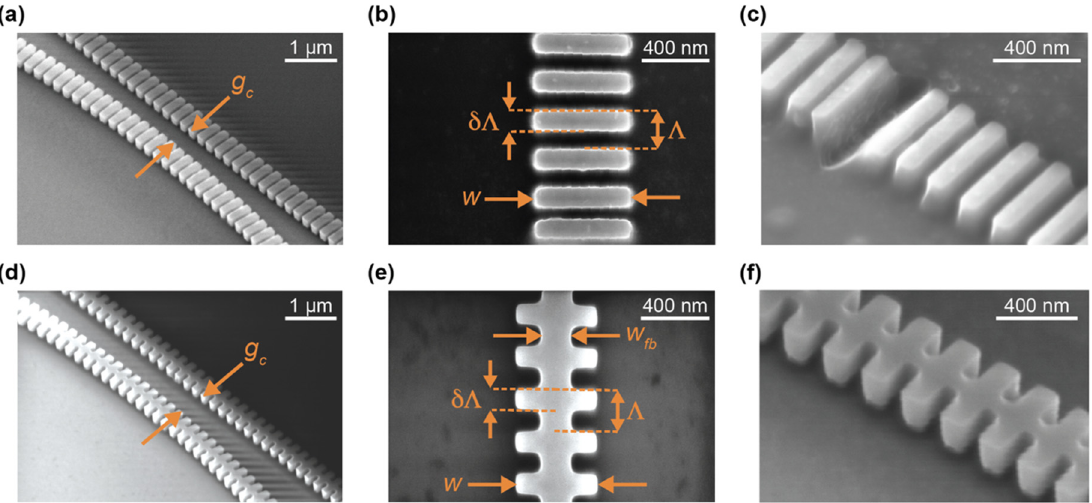
Figure 7. Scanning electron microscope images of fabricated SWG MRRs. ( a ) 45° angled view of coupling region for a boneless SWG MRR, ( b ) top-view of boneless SWG waveguide O4, ( c ) 45° angled view of boneless SWG waveguide O4, showing collapsed silicon pillars after testing, highlighting robustness issues with this boneless design (we did not observe any collapsed pillars in images acquired after fabrication but prior to testing with water), ( d ) 45° angled view of coupling region for a fishbone SWG MRR, ( e ) top-view of fishbone SWG waveguide C1, and ( f ) 45° angled view of fishbone SWG waveguide C2.